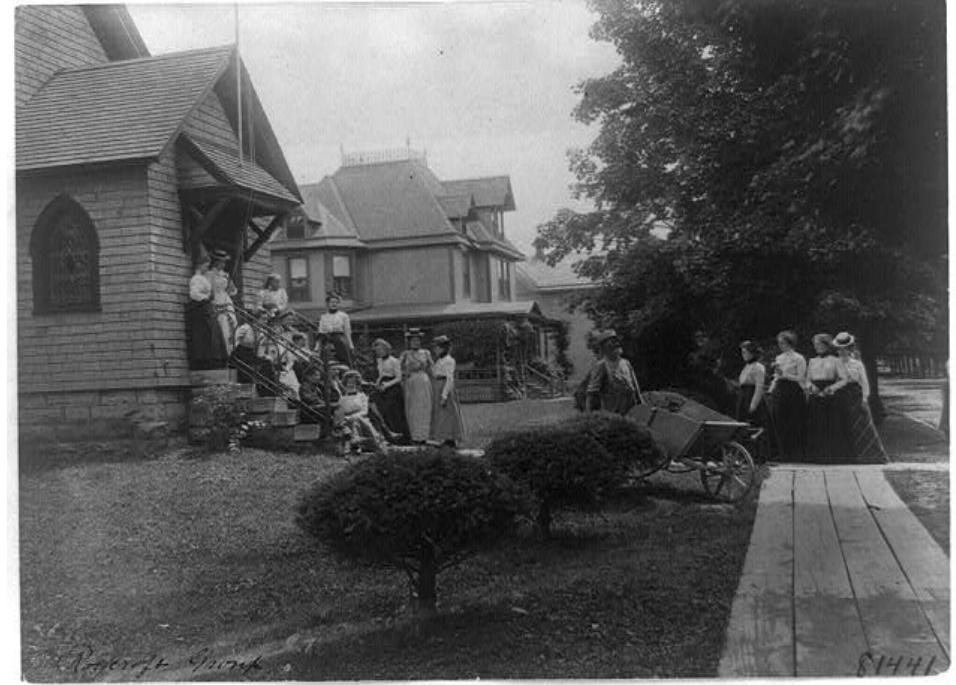
Figure 28. Frances Benjamin Johnson 1900. Women sitting outside the Roycraft Shop. Library of Congress.